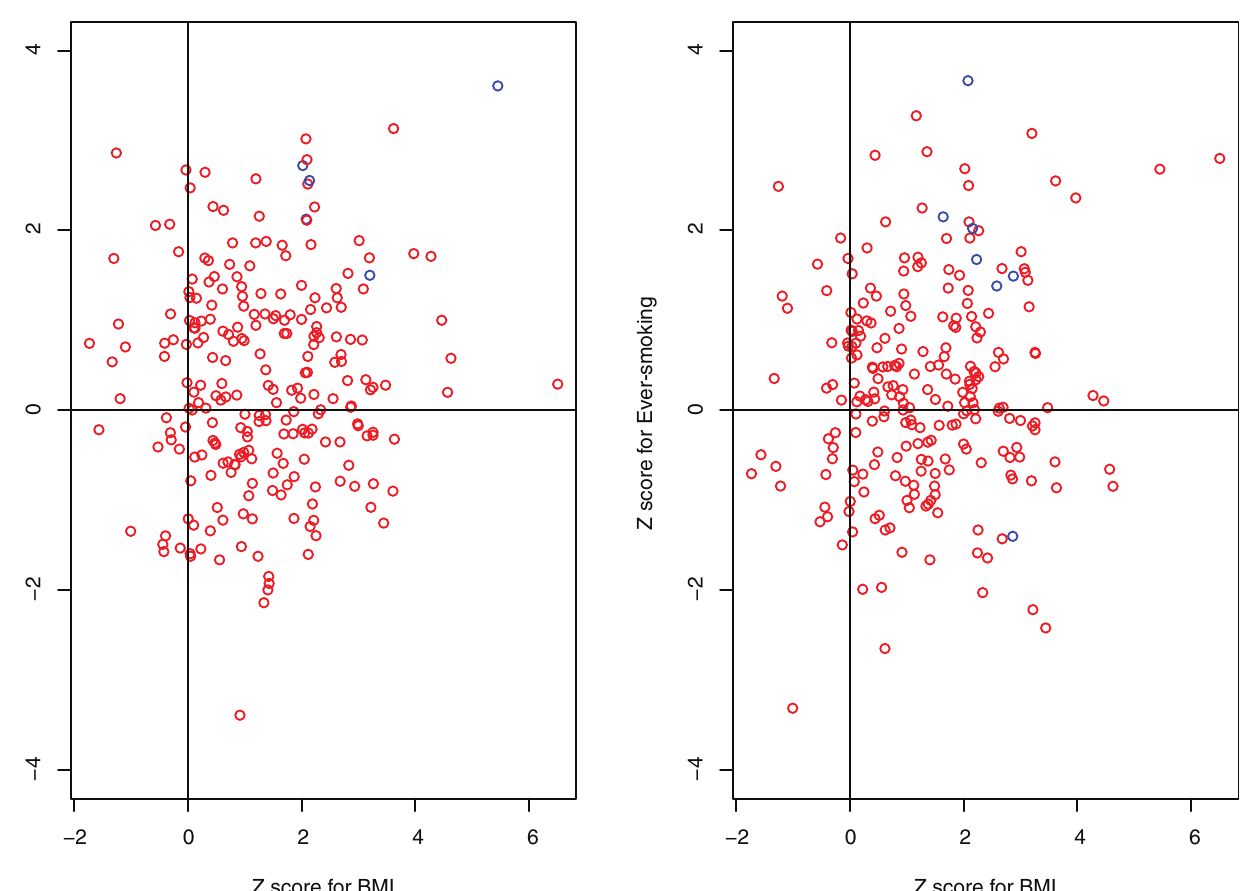
Fig 4. The Z statistics for associations of 241 SNPs with BMI, pack-years of smoking, and smoking. The vertical axis represents Z scores for associationsof SNPs with pack-years of smoking or smoking. The horizontal axis represents Z scores for associations of SNPs with BMI. All Z scores were adjustedby age, sex, study sites, geneticprincipalcomponentsand lung cancer diseasestatus. The blue dots were SNPs that were determined to be pleiotropicwith further validationin TAG.